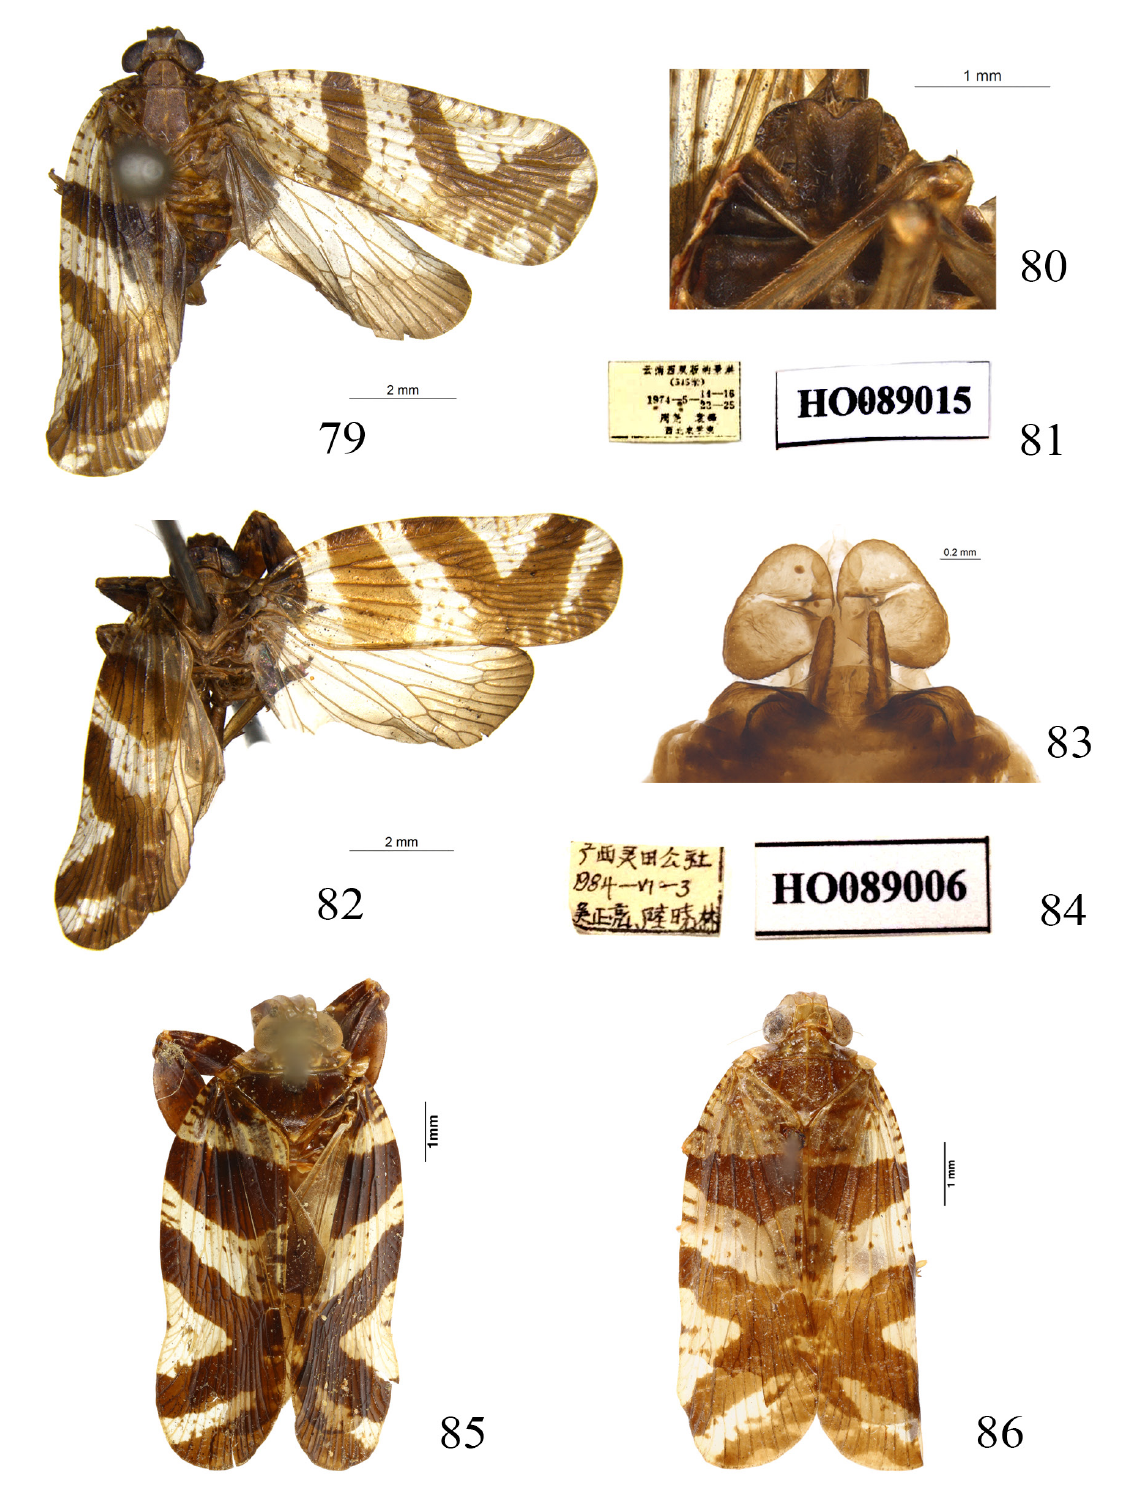
Figs 79–86. Lacusa Stål, 1862 specimens. 79–81 . ♀ from China, Yunnan Province. 79 . Habitus, dorsal view. 80 . Female terminalia, ventral view. 81 . Labels. 82–84 . ♀ from China, Guangxi Province: L. fuscofasciata (Stål, 1854). 82 . Habitus, dorsal view. 83 . Female terminalia, ventral view. 84 . Labels. 85 . ♂ from Tonkin, Lao-Kay; habitus, dorsal view. 86 . ♂ from Vietnam, Mt Lang Bian; habitus, dorsal